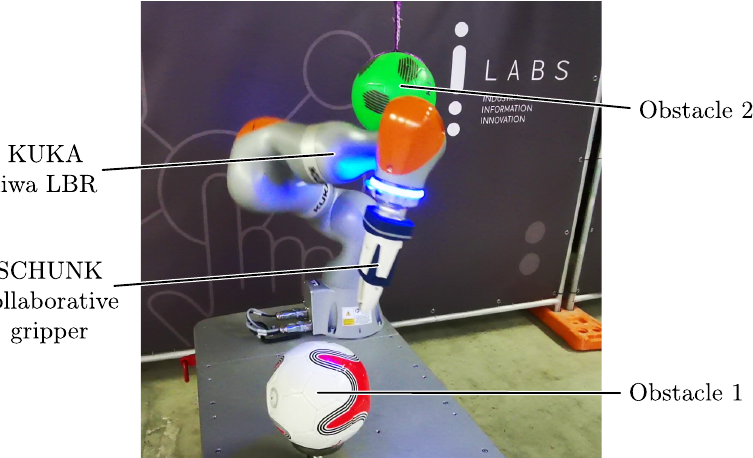
Figure 6. Experimental test rig: the KUKA iiwa LBR avoiding two different obstacles in its workspace.